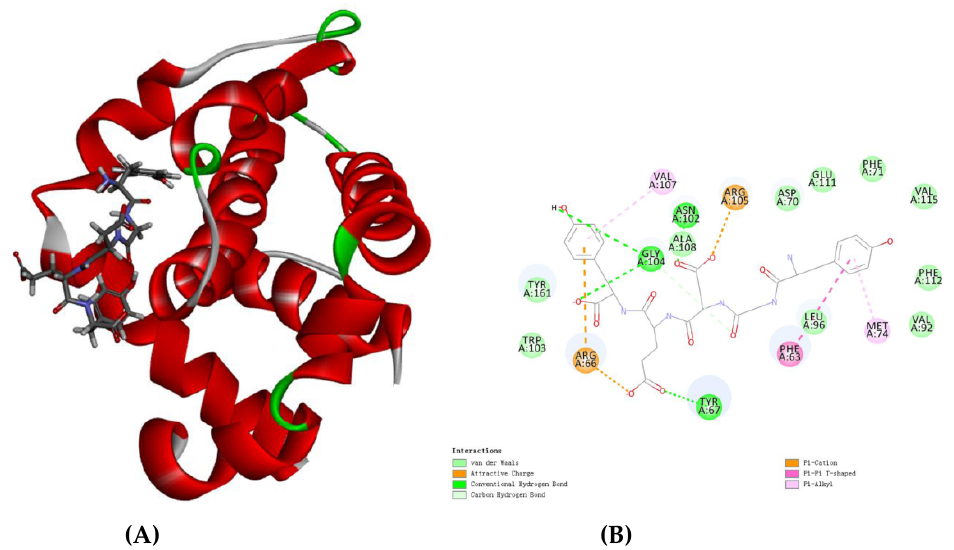
Figure 9. ( A ) The optimal docking structure of YGDEY and bcl-2; ( B ) 2D model of the interaction between YGDEY with the active site of bcl-2. YGDEY is represented by lines, and hydrogen bonds are shown with green dashed lines.